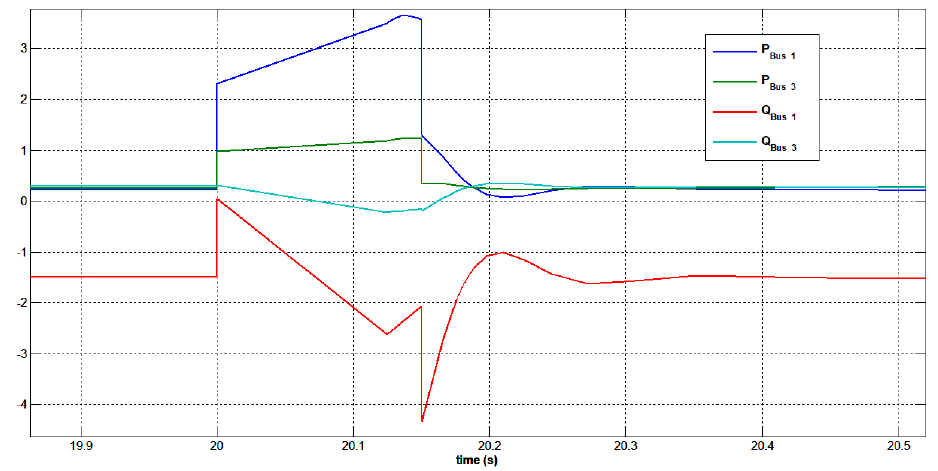
Figure 43. Generated active and reactive power at buses 1 and 3 under a three-phase short circuit at bus 15 without STATCOM.